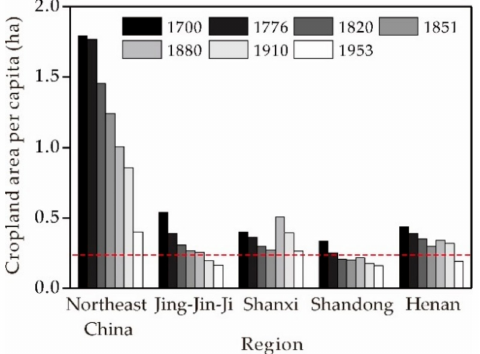
Figure 8. PCA values for di ff erent regions between 1700 and 1953. The red dashed line on this graph denotes minimum PCA, 0.27 ha [66,67]. Human population and cropland data were sourced from references